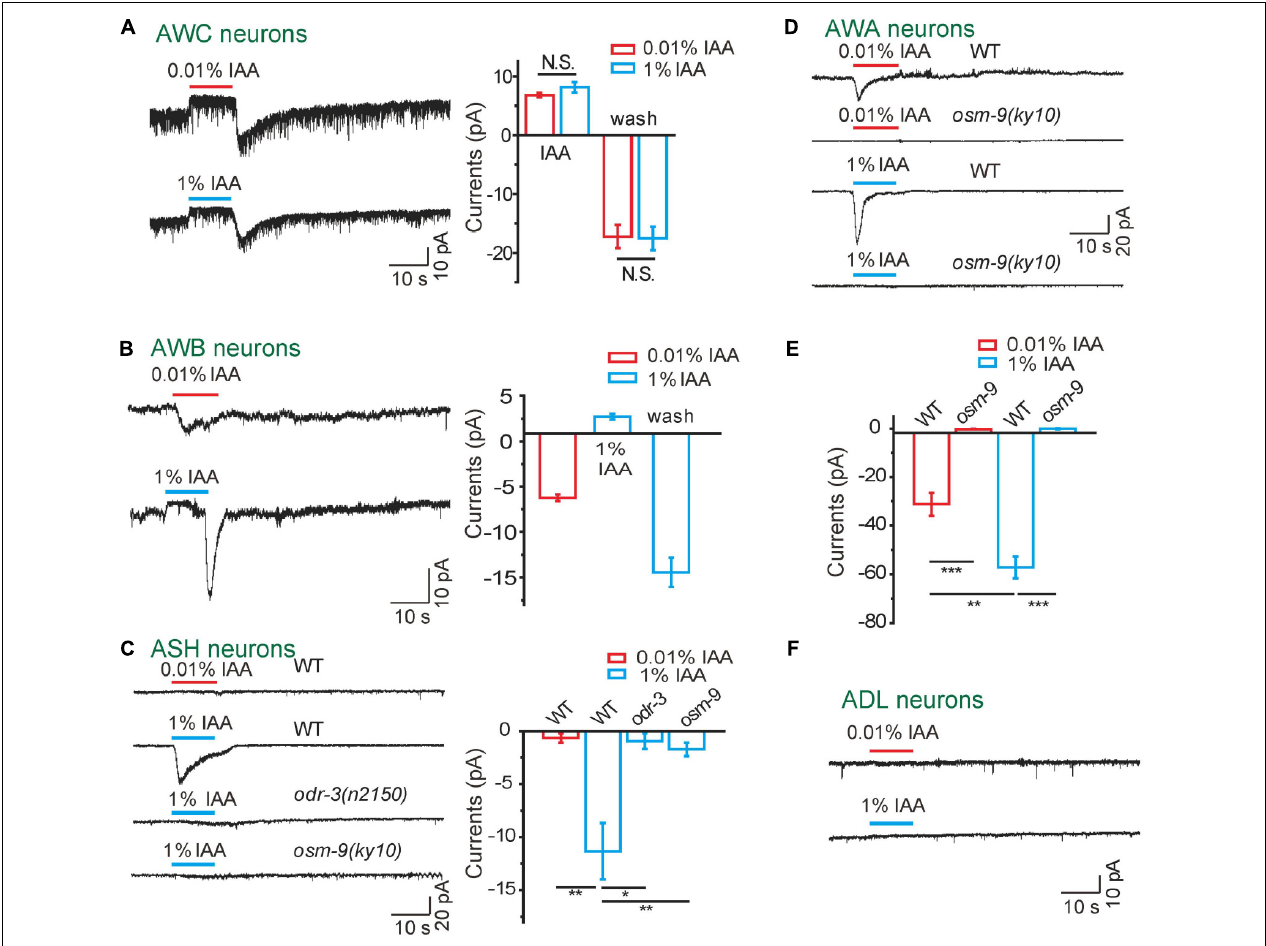
FIGURE 1 | Odorants induced diverse currents from olfactory neurons in an intensity-dependent manner. (A) IAA induced bi-directional currents from AWC neurons. (Left) Representative traces. (Right) Quantification of the currents. n ≥ 6. (B) 1 and 0.01% IAA-induced opposite currents from AWB neurons. (Left) Representative traces. (Right) Quantification of the currents. n ≥ 6. (C) 1%, but not 0.01% IAA, induced inward currents from ASH neurons, which were mediated by ODR-3 and OSM-9. (Left) Representative traces. (Right) Quantification of the currents. n ≥ 7. (D,E) Both 0.01 and 1% IAA induced OSM-9-dependent inward currents from AWA neurons. (D) Representative traces. (E) Quantification of the currents. n ≥ 5. (F) Neither 0.01% nor 1% IAA induced detectable currents from ADL neurons. Representative traces were shown. n ≥ 6. The cell membrane potential was voltage-clamped at –70 mV. Error bars: SEM. N.S., not significant, * P < 0.05, ** P < 0.01, *** P < 0.001.